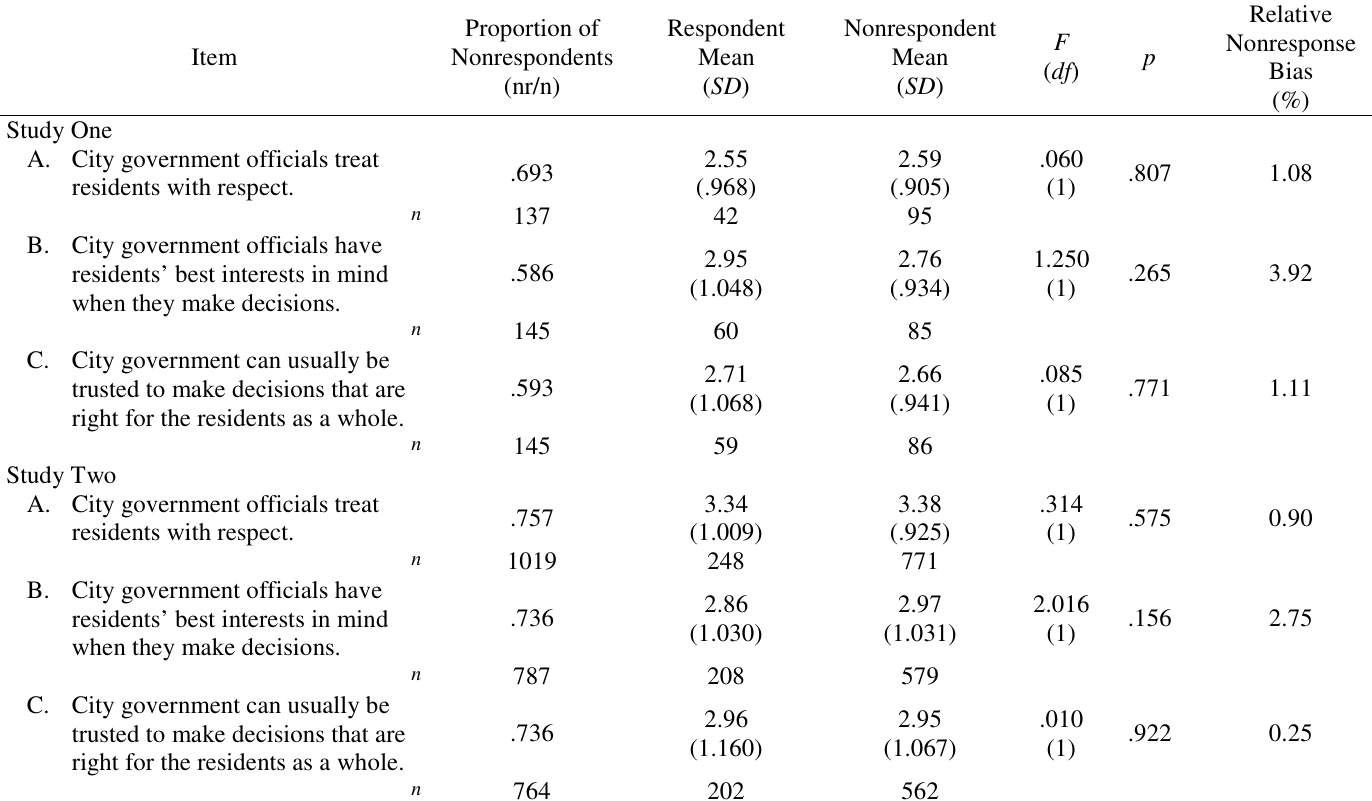
Table 4. Invitation nonresponse